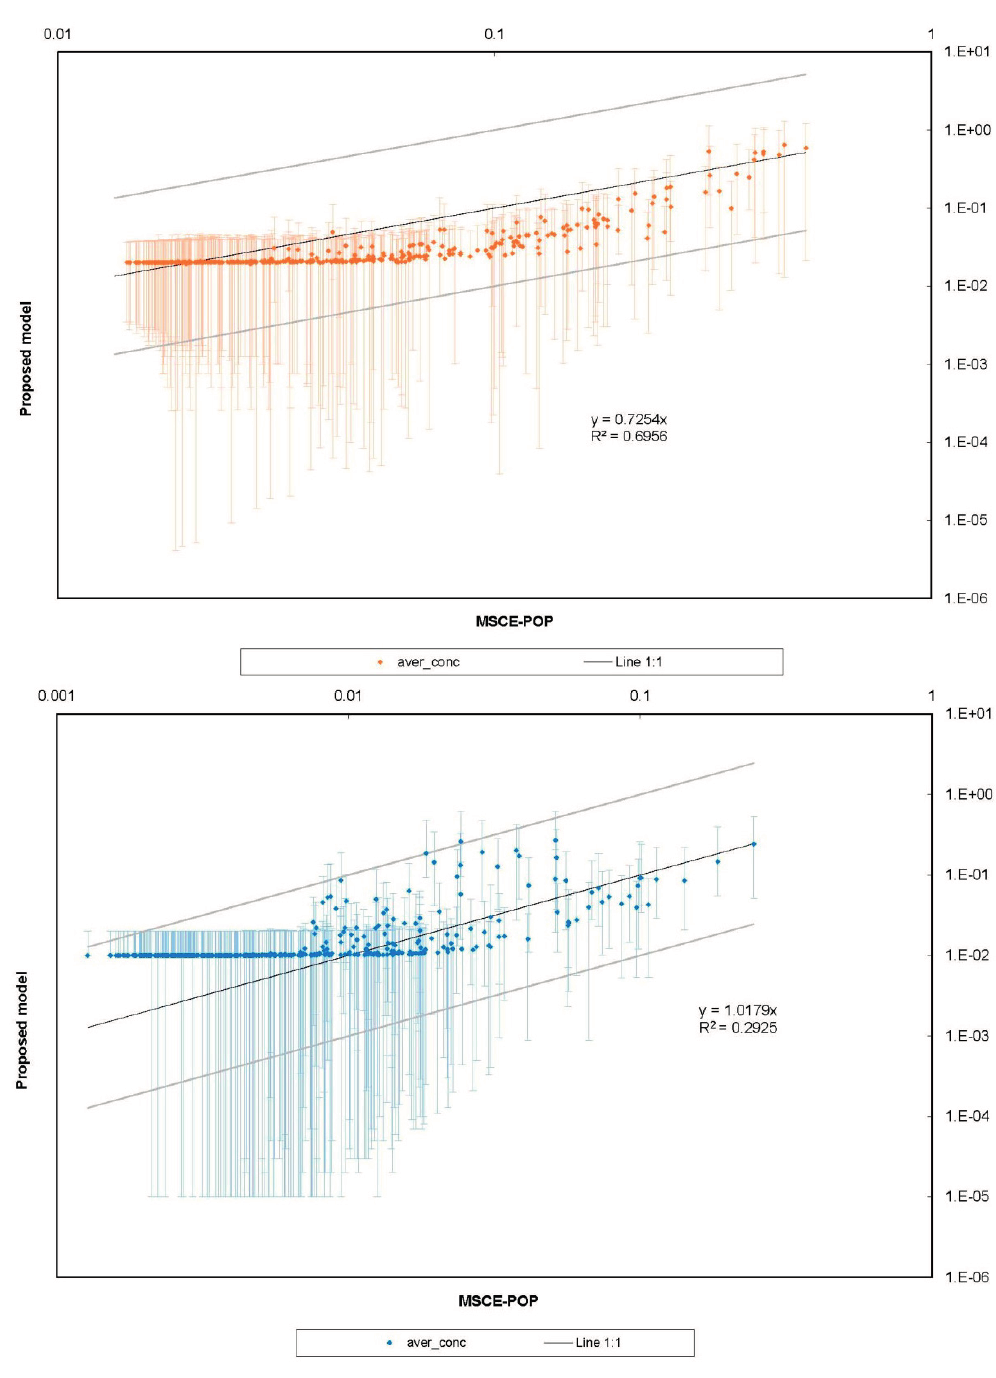
Figure 5. Comparison of average concentrations in µg/m 3 in the atmosphere in 1995 and 2005 derived from Equation (5) and the MSCE-POP model, respectively, considering background concentrations from extracontinental